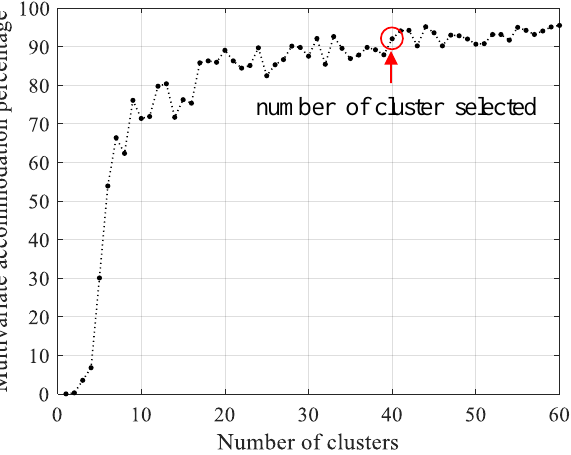
Figure 5. Determination of an optimal number of clusters (illustrated). The number of anthropometric dimensions ( n ) = 10 and anthropometric cases within 90% ± 1% boundary zone = 60.